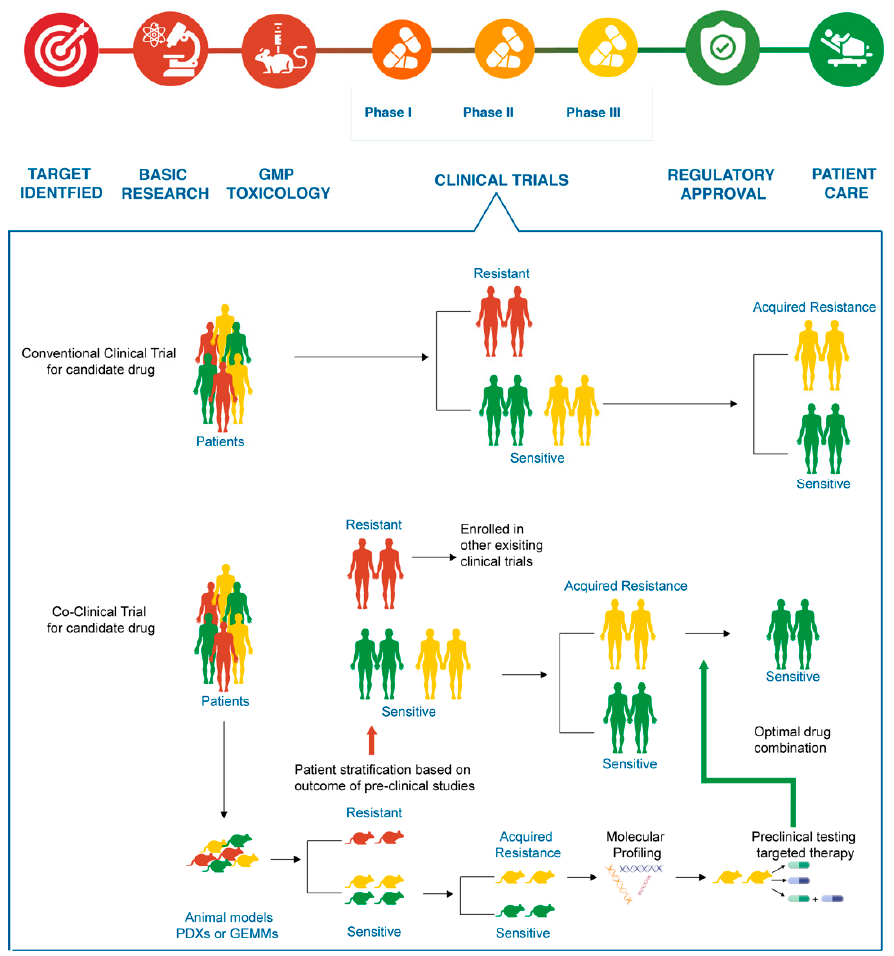
Figure 1. The conventional drug development process versus co-clinical trials. The different phases of clinical trials in the conventional drug development process take approximately 10–20 years for regulatory approval of the candidate drugs. Preclinical studies with animal models and clinical trials are conducted concurrently in co-clinical trials. The real-time data integration between the two parallel studies can accurately stratify patients into resistant or sensitive subtypes. The patients classified into resistant subtypes can be tested for enrolment in other existing clinical trials. The patient cohorts of the sensitive phenotype are then recruited to the trial with the animal study conducted in parallel. This will improve trial outcomes for candidate drugs and therefore encourage regulatory approval.